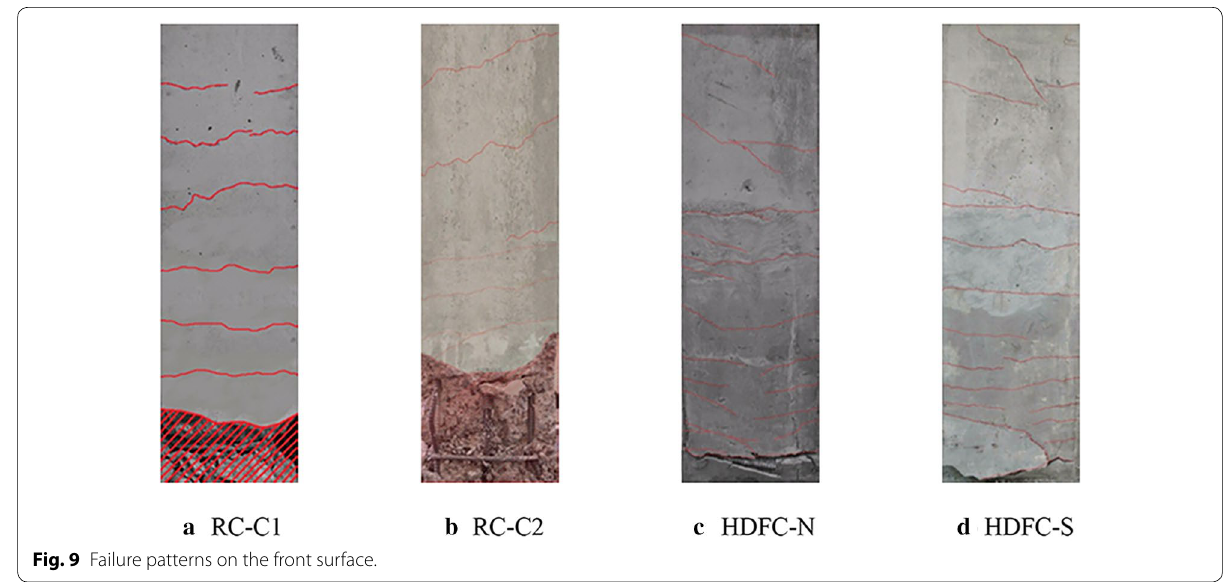
Fig. 9 Failure patterns on the front surface.